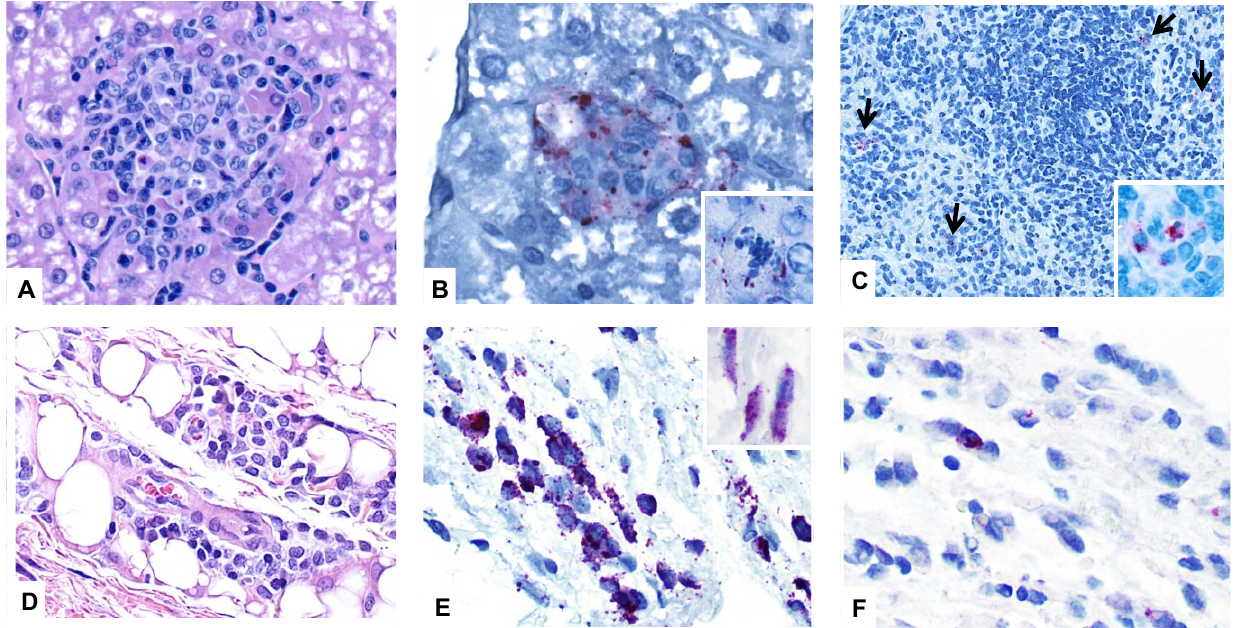
Figure 4. Photomicrographs of tissues from Egyptian rousette bats experimentally inoculated with filoviruses. ( A ) Liver, MARV-inoculated bat, day 5 post-inoculation (pilot study). A focus of histiocytic infiltrate and rare necrotic hepatocytes disrupts the parenchyma. H&E stain; ( B ) Liver, MARV-inoculated bat, day 5 post-inoculation (pilot study). Marburgviral antigen (red) is present in the cytoplasm of hepatocytes and macrophages in a small focus of infiltrate. Inset: positive immunostaining in the cytoplasm of a necrotic hepatocyte from the same section. Immunoalkaline phosphatase with naphthol fast red and hematoxylin counterstain; ( C ) Spleen, MARV-inoculated bat, 5 days post-inoculation (pilot study). MARV antigen is present in small numbers of red pulp macrophages (arrows). Inset: Higher magnification of cytoplasmic antigen in macrophages. Immunoalkaline phosphatase with naphthol fast red and hematoxylin counterstain; ( D ) Skin (subcutaneous tissue) from the inoculation site, MARV-inoculated bat, 5